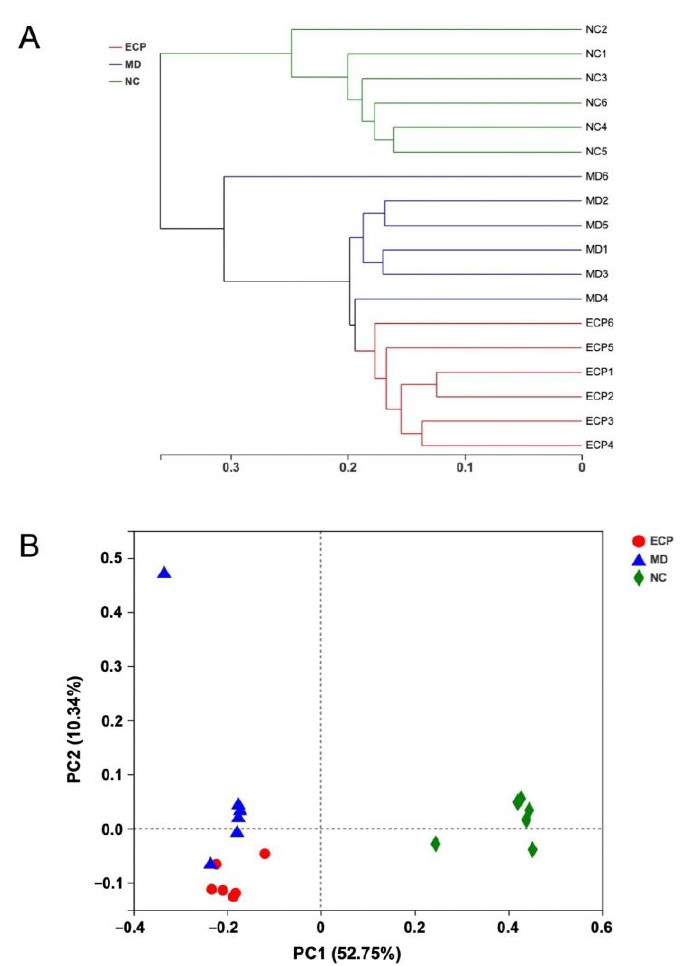
Figure 2. Oral intake of ECP significantly changed the structure of the gut microbiota in HFD-fed mice. Clustering analysis of the gut microbiota ( A ). PCA score plot of gut microbiota ( B ). 3.3. Dietary ECP Modulated the Composition of the Gut Microbiota at the Phylum